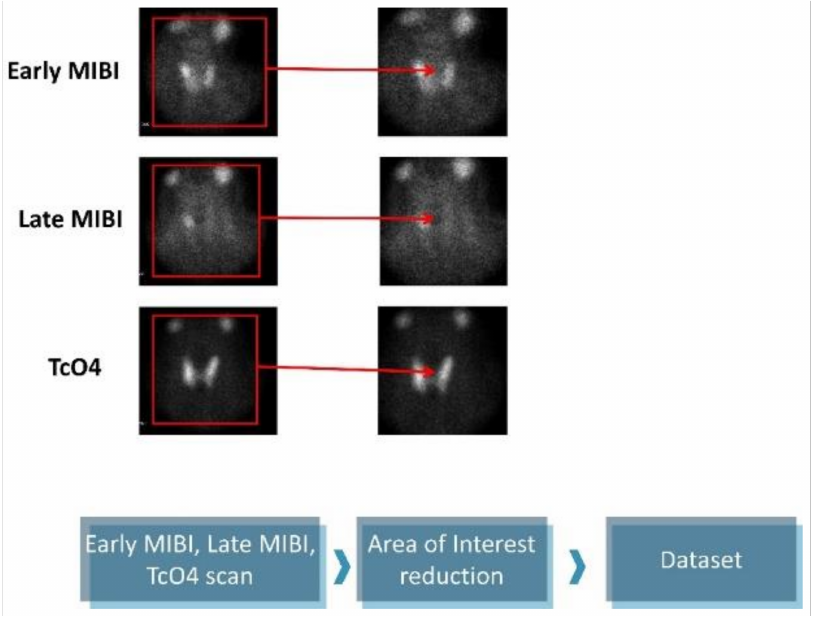
Figure 1. Data preprocessing.